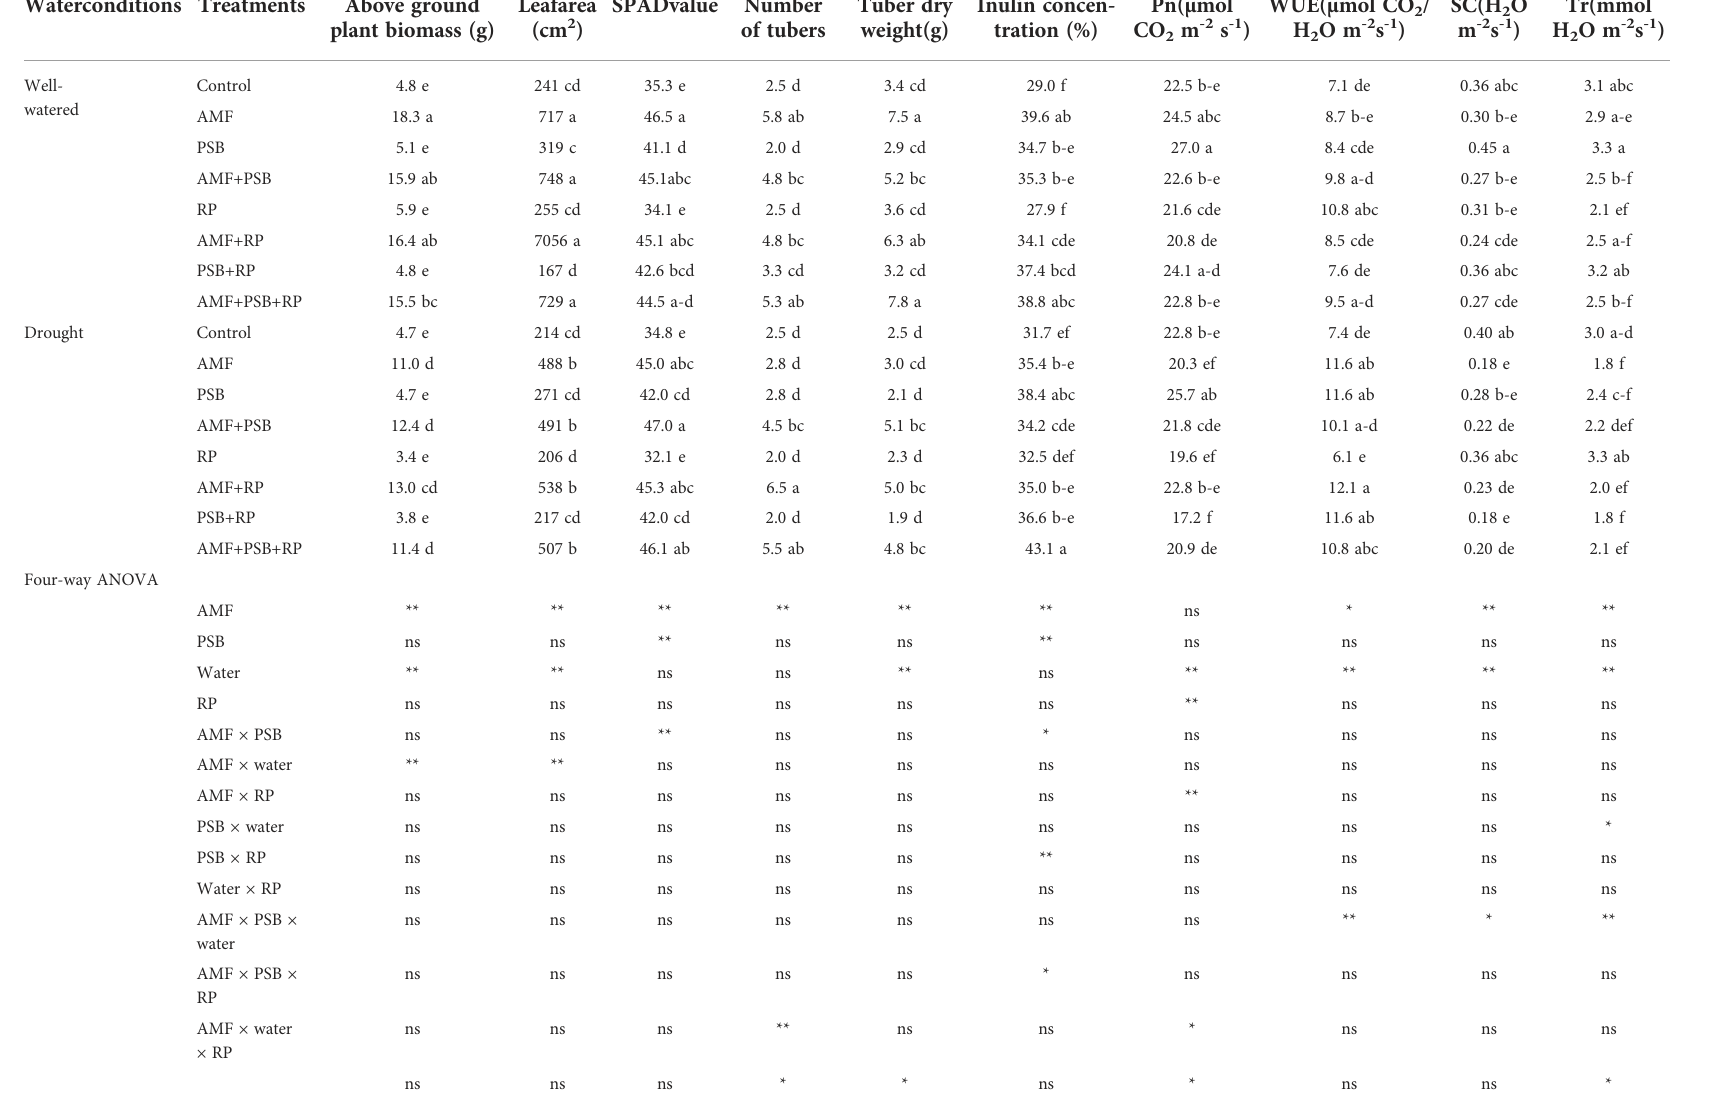
TABLE 2 Plant performance of sunchoke treated with AMF and PSB under well-watered (WW) and drought (DS) conditions, in the presence and absence or RP, evaluated at 60 DAT. Waterconditions Treatments